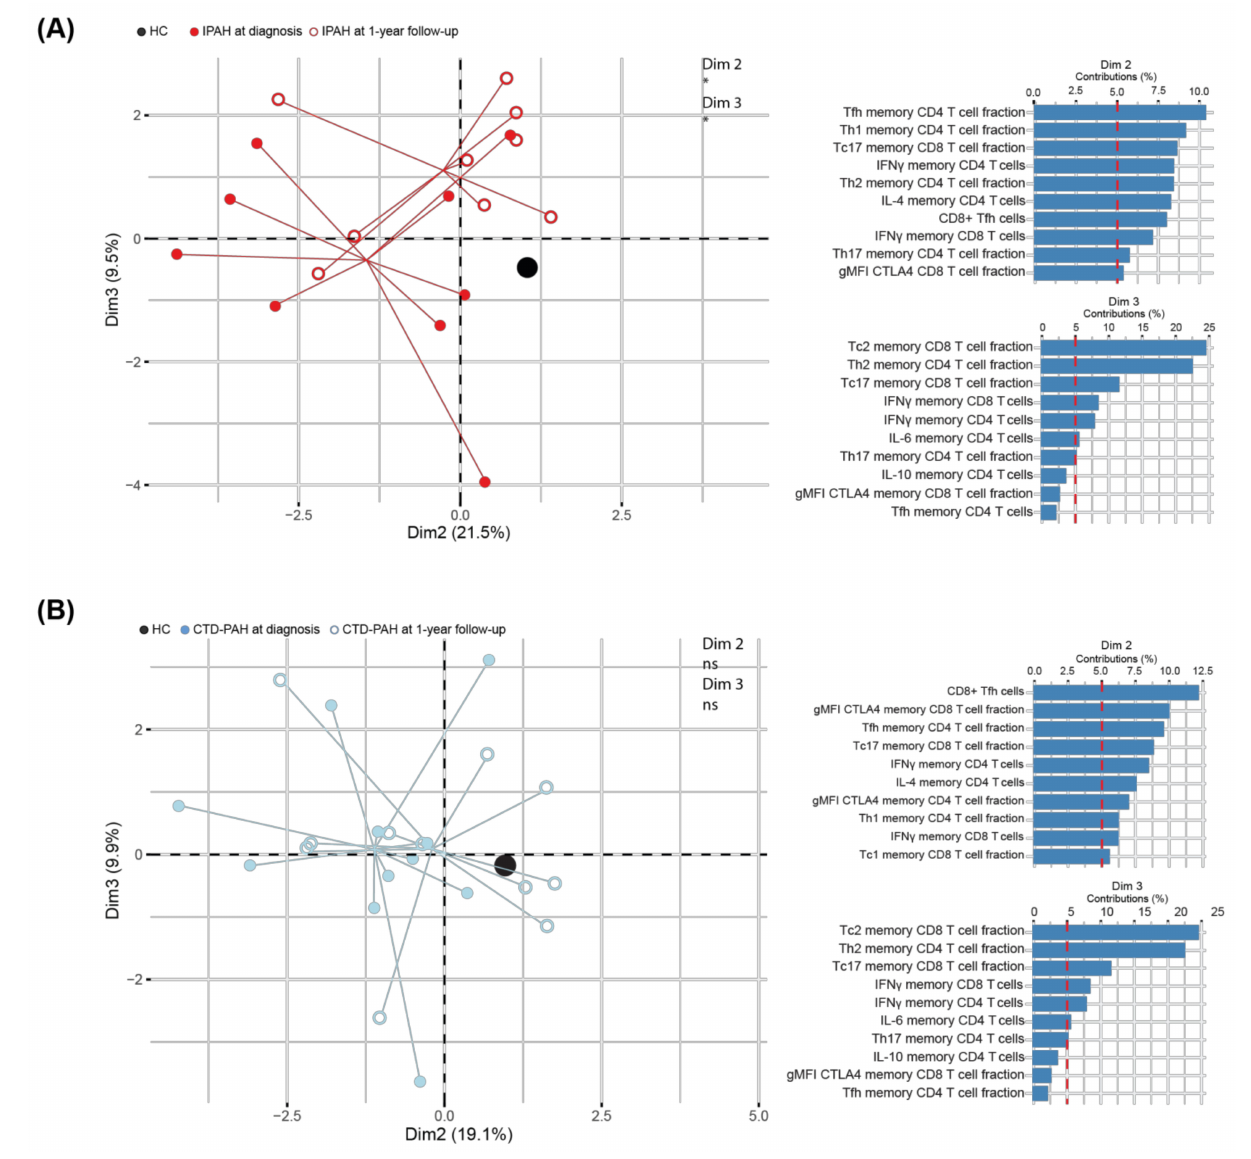
Figure 5. Multivariate analysis separates IPAH patients but not CTD-PAH patients at diagnosis and 1-year follow-up. ( A , B ) Principal component analysis (PCA) of IPAH patients ( n = 9) ( A ) and CTD-PAH patients ( n = 11) of whom all variables (peripheral T cell subsets, activation markers and cytokine production) could be determined by flow cytometry at 1-year follow-up ( left ), with the contributions of the top 10 variables in percentages of Dim2 and Dim3 ( right ). Symbols represent values of individual patients or HCs, whereby lines connect these values to the mean Dim2 and Dim3 coordinates. Mean coordinates of HCs are indicated in black. Wilcoxon matched-pairs signed-rank test was used for statistical analysis, * p <